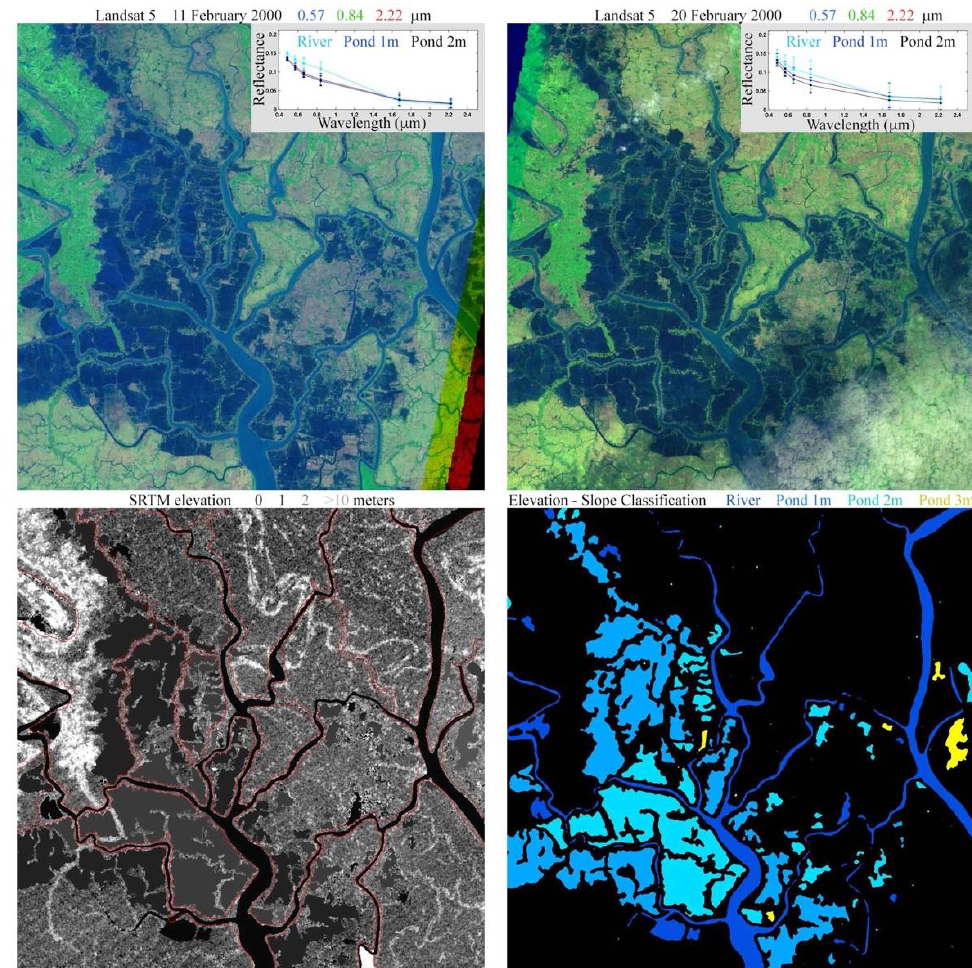
Figure 9. Comparison of river and pond reflectance at the beginning and end of the SRTM mission in February 2000. On 11 February, river water reflectance was > 1 σ brighter in visible/NIR bands than pond water (upper left) but, by 20 February, the river water reflectance distribution overlapped that of pond water at all wavelengths (upper right). SRTM elevations (lower left; single channel grayscale) clearly distinguish water bodies as flat, allowing them to be classified by both elevation and slope (lower right) to select spectra. Landsat 5 images (top row) are false color composites: red = SWIR reflectance; green = NIR reflectance; blue = visible reflectance (TM bands 6, 4, and 2). Lower right image is a discrete classification with colors chosen to emphasize contiguous clusters.